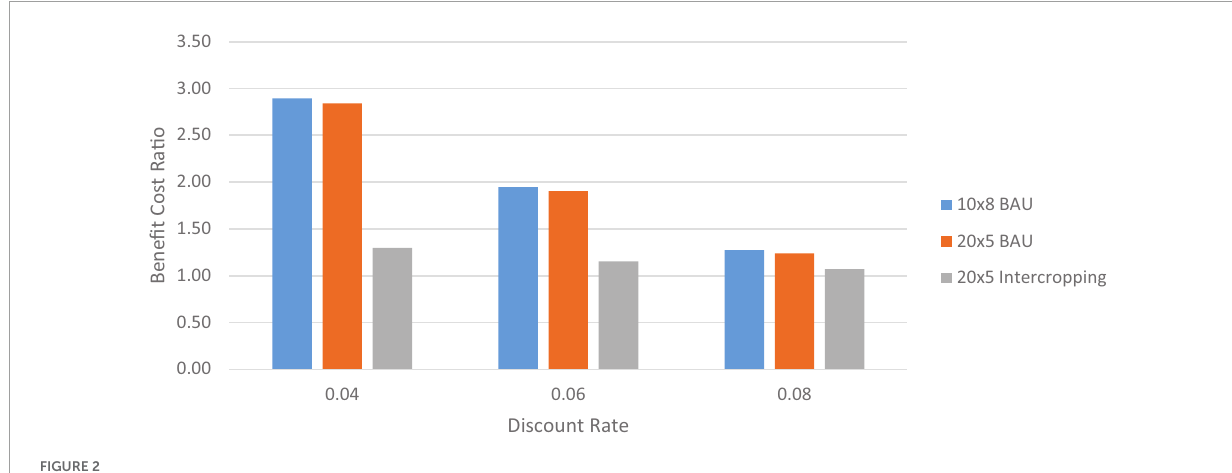
FIGURE2 Benefit-Cost Ratio (BCR) from monoculture loblolly and intercropping scenarios under the discount rate of 4%, 6%, and 8%.